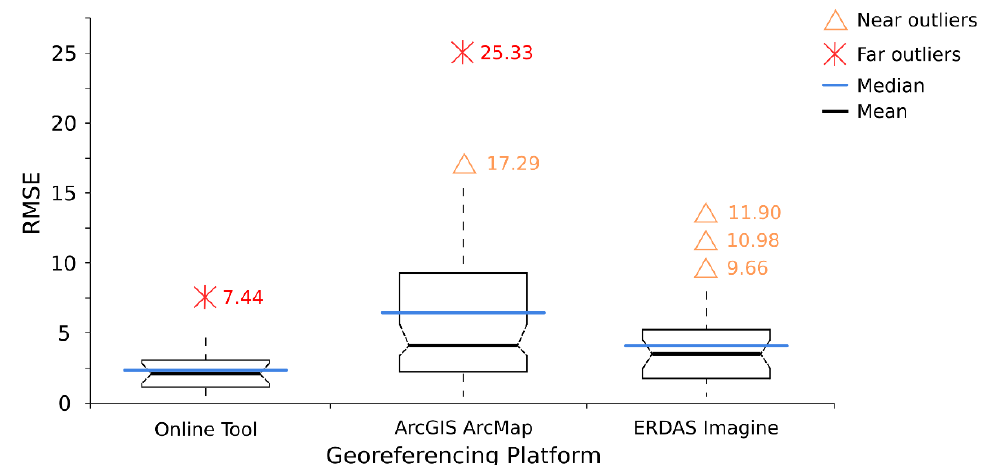
Figure 9. The box plot of the RMSE derived from three georeferencing platforms.